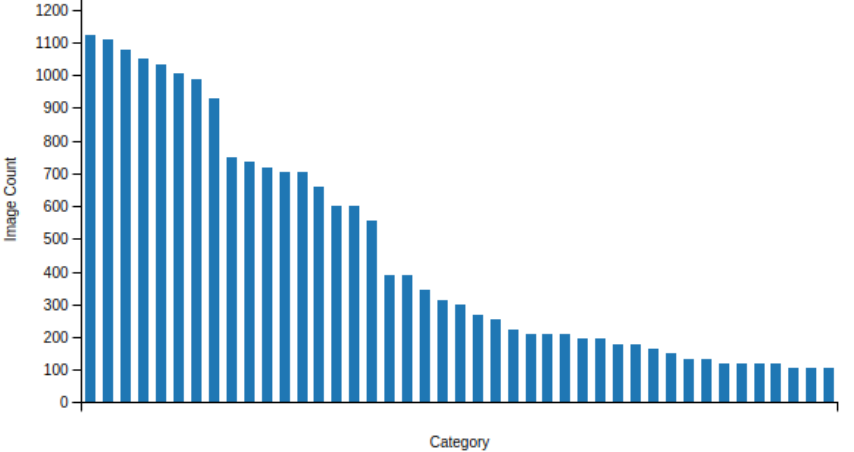
Figure 6. Number of images per traffic sign in the GTSRB